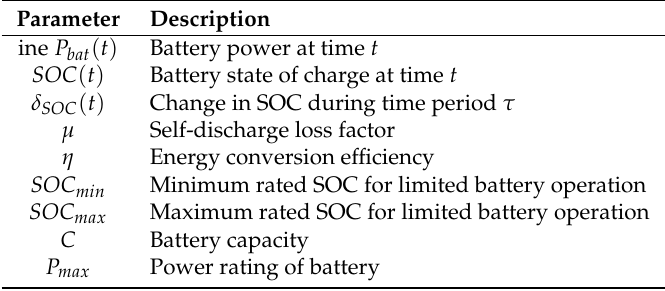
Table 3. Table of the notation used in this